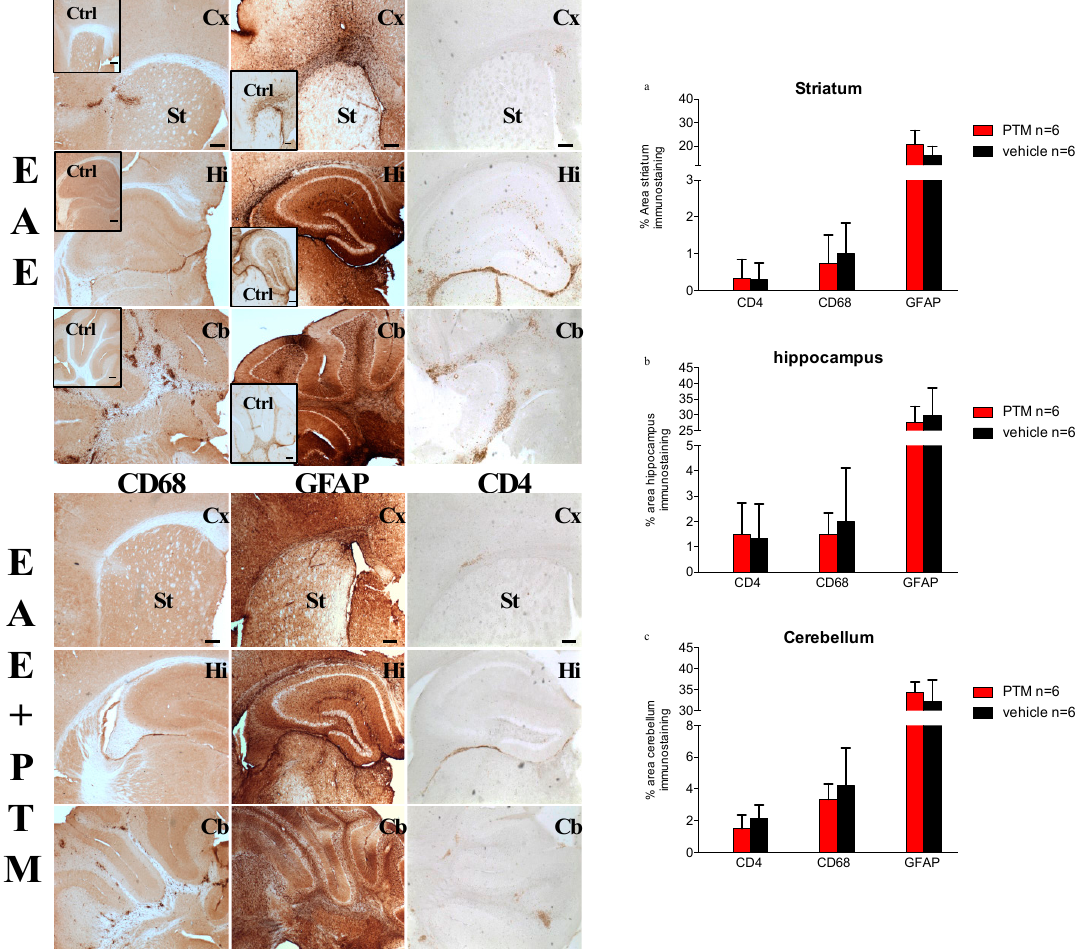
Figure 3. Effects of pentamidine (PTM) on immune infiltrates and glial fibrillary acidic protein (GFAP) in the central nervous system (CNS) of RR–EAE mice. EAE ( n = 6) and EAE–PTM ( n = 6) mice were sacrificed 30 days after immunization in the relapse/late onset of EAE (sacrificed when they reached at least 0.5 point of CSS above their individual remission mean CSS). Immunohistochemistry was performed with CD68, GFAP, and CD4 antibodies on serial brain emisections (30 μ m) of control (Ctrl), EAE, and EAE–PTM mice. Cx = cortex; St = striatum; Hi = Hippocampus; Cb = cerebellum. Scale bars = 250 μ m. The quantifications are displayed on the bar graph on the right of the figure (EAE–PTM-treated in red versus EAE-vehicle treated in black). Immunocytochemistry and DAB assays revealed that pentamidine seems to decrease the expression of CD68 in all the analyzed areas ( a – c ). CD4 infiltrates seem to be reduced by PTM in cerebellar area only ( c ), and GFAP percentages are increased in all the areas except in hippocampus ( b ). All these regional cell counts, although not significant, would indicate a different impact of the inhibition of S100B within each cerebral area.